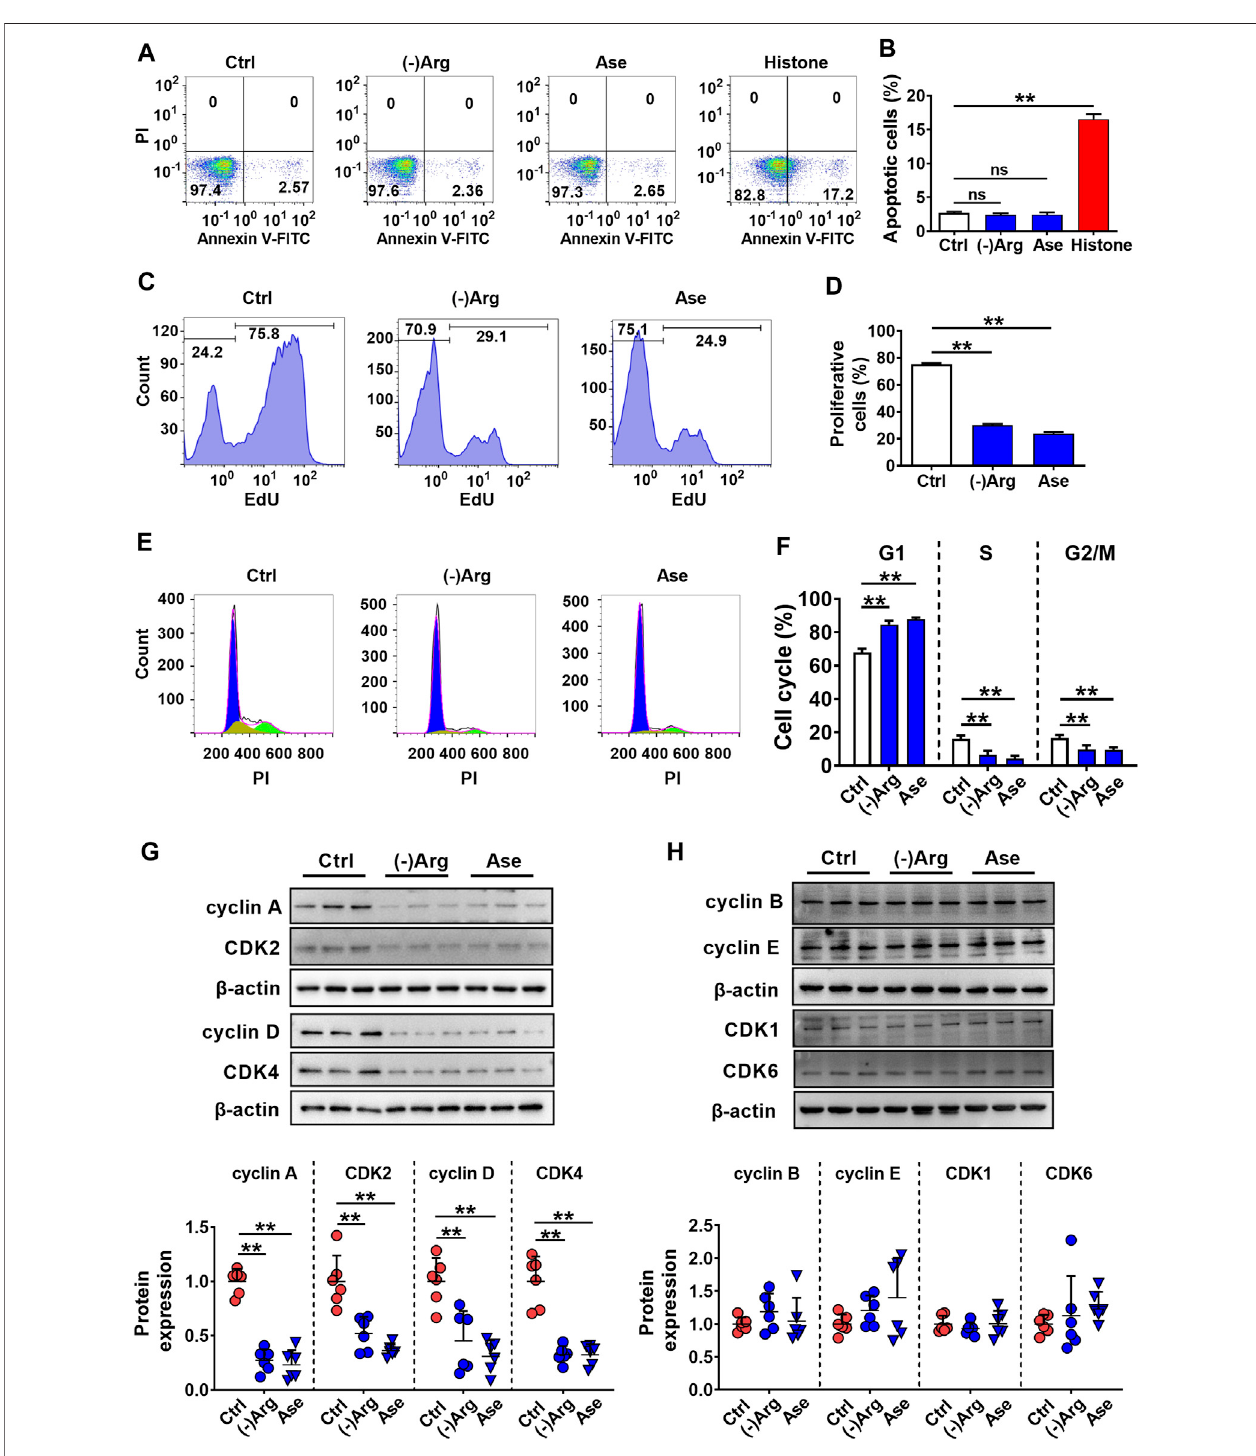
FIGURE 5 | Both arginase and Arg de fi ciency impaired hCMEC/D3 cells via inhibiting cell proliferation. (A,B) Cell apoptosis analysis by Annexin Ⅴ -FITC/PI staining of hCMEC/D3 cells treated with Arg-free culture ((-)Arg), arginase (20 μ g/ml) (Ase), or histone (10 μ g/ml) ( n (cid:2) 4). (C,D) Cell proliferation assay by EdU incorporation of hCMEC/D3 cells treated with (-)Arg or Ase ( n (cid:2) 4). (E, F) Cell cycle analysis by PI staining of hCMEC/D3 cells treated with (-)Arg or Ase ( n (cid:2) 4). (G, H) Western blot of cell cycle – related proteins in hCMEC/D3cells treated with (-)Arg or Ase( n (cid:2) 6). Datawere expressed asmean ± SD. ** p < 0.01; ns, no signi fi cance versus control (Ctrl) cells; 1-way ANOVA followed by Dunnett ’ s post hoc